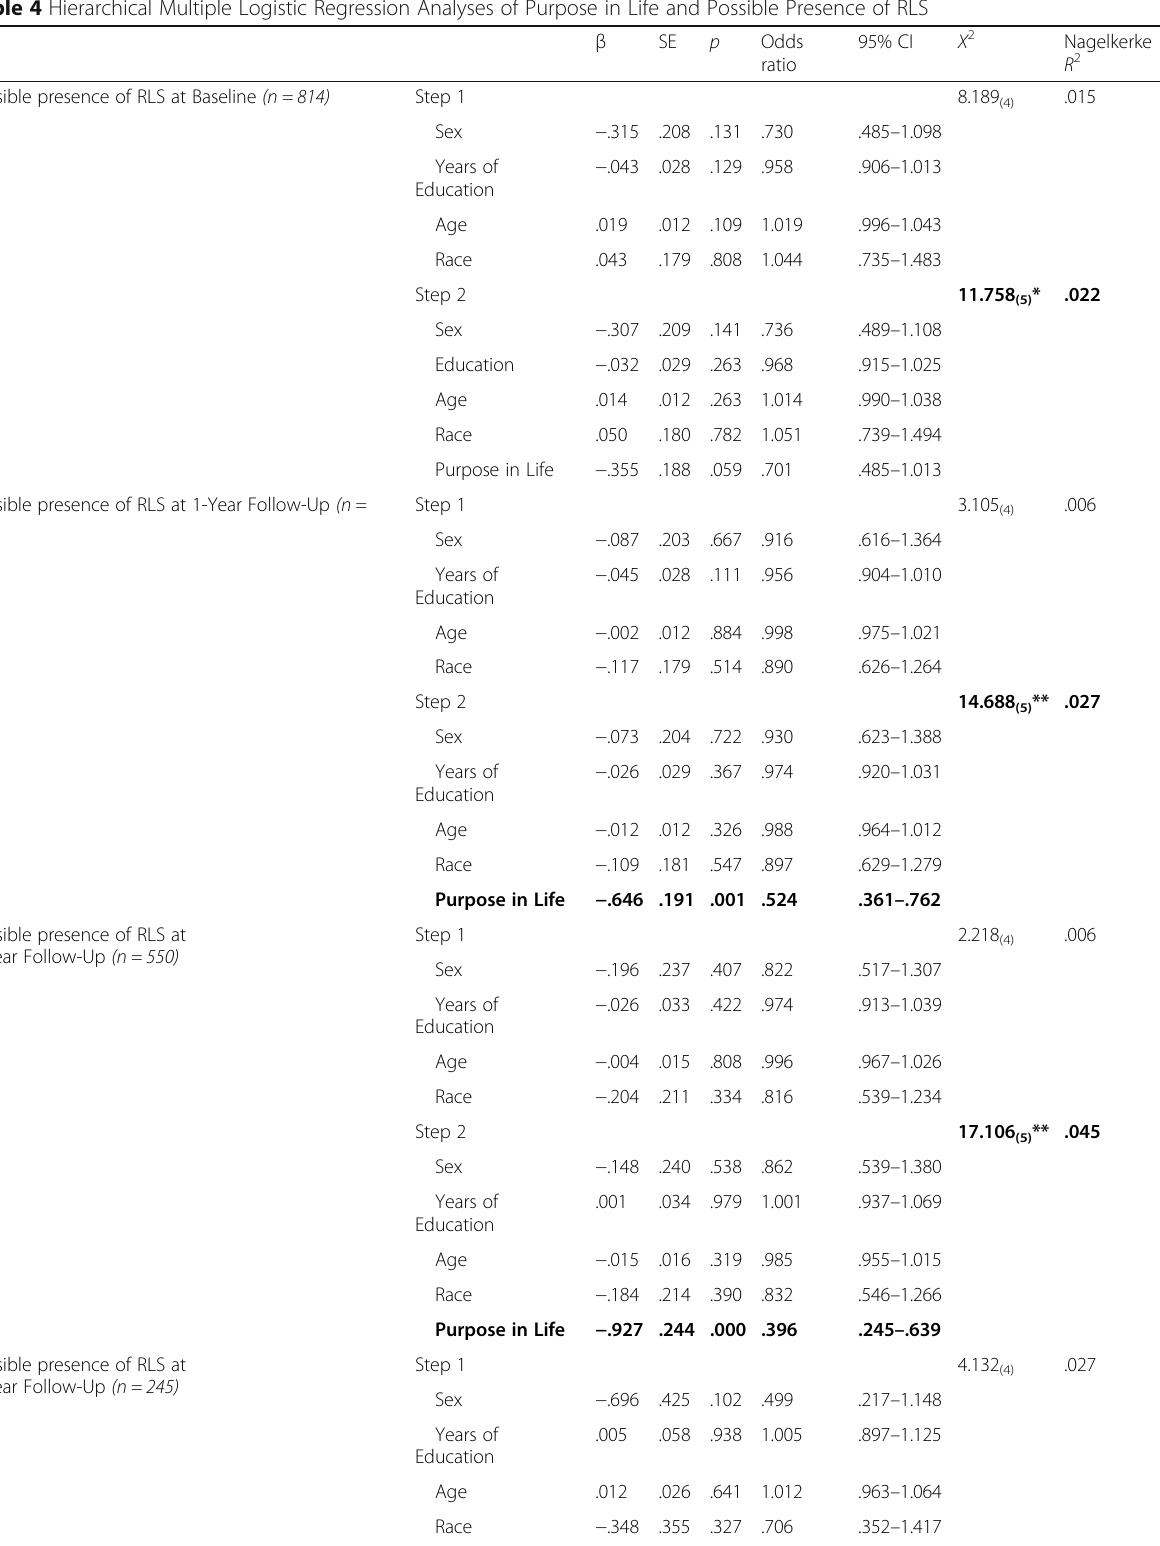
β SE p Odds 95% CI Χ 2 Nagelkerke R 2 ratio